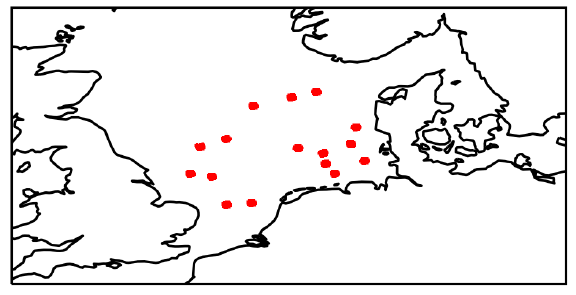
Figure 8. Candidate hub locations in the North Sea region.